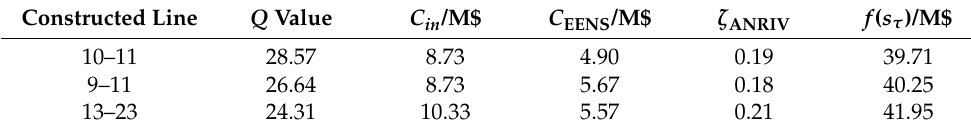
Table 4. Comparison of indexes and costs under three line-building